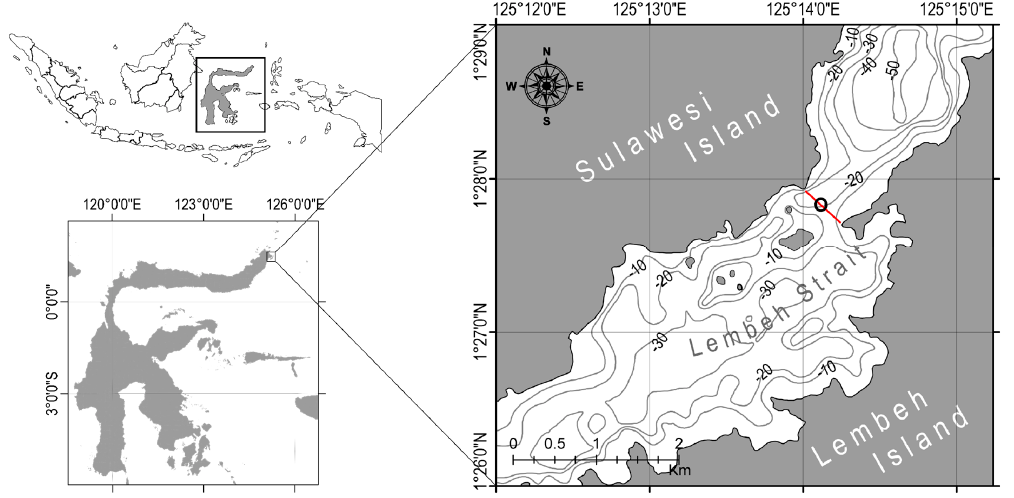
Figure 1. Moored ADCP and zooplankton sampling point ( o ) location and mobile ADCP survey transect line ( – ) in the Lembeh Strait, North Sulawesi, Indonesia in April 2016.